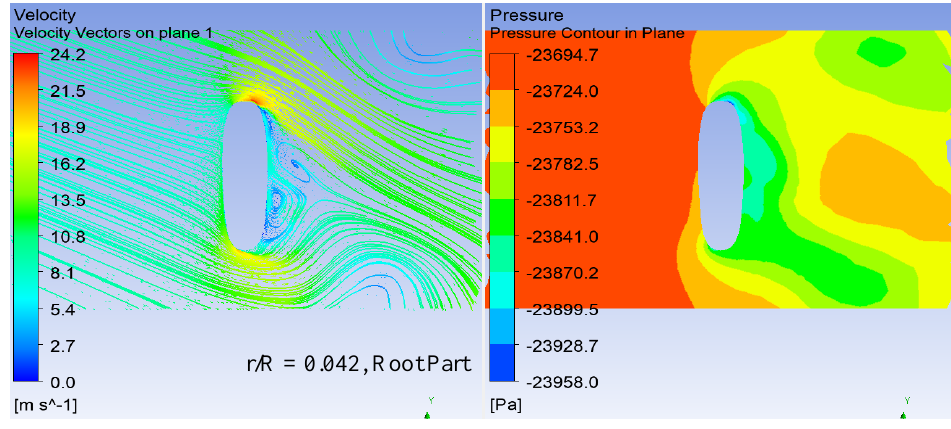
Figure 3. 3D geometry of the designed blade: ( a ) using Matlab and ( b ) using